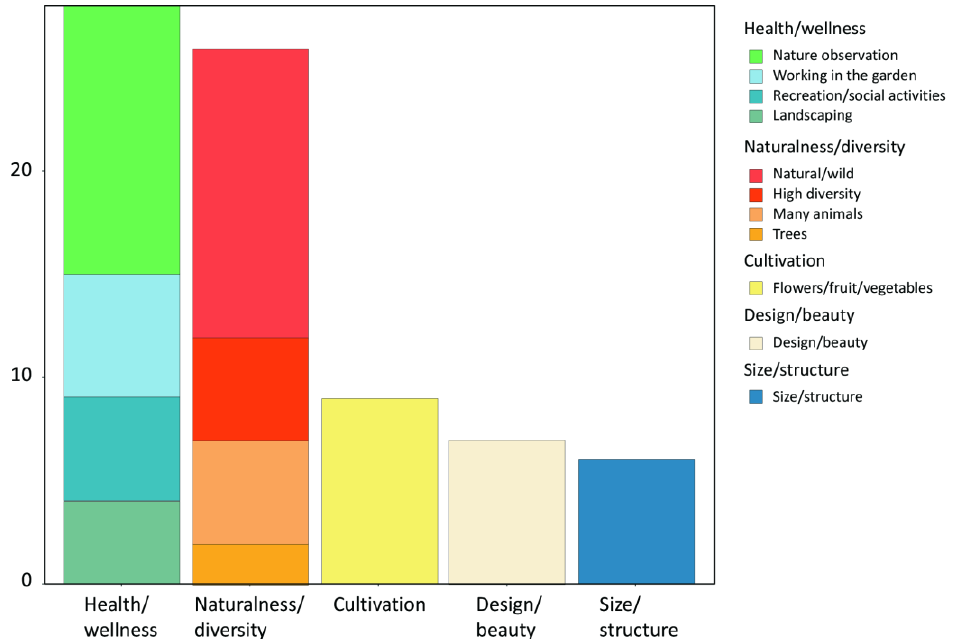
Figure 1. Gardens provide different sources of joy to owners. Responses to the open question “In your garden: what does especially please you?” by interviewed garden owners. Multiple answers were allowed. Answers were later assigned to five main categories. Note that activities including nature observation (bird watching) were considered as belonging to the health/wellness category.